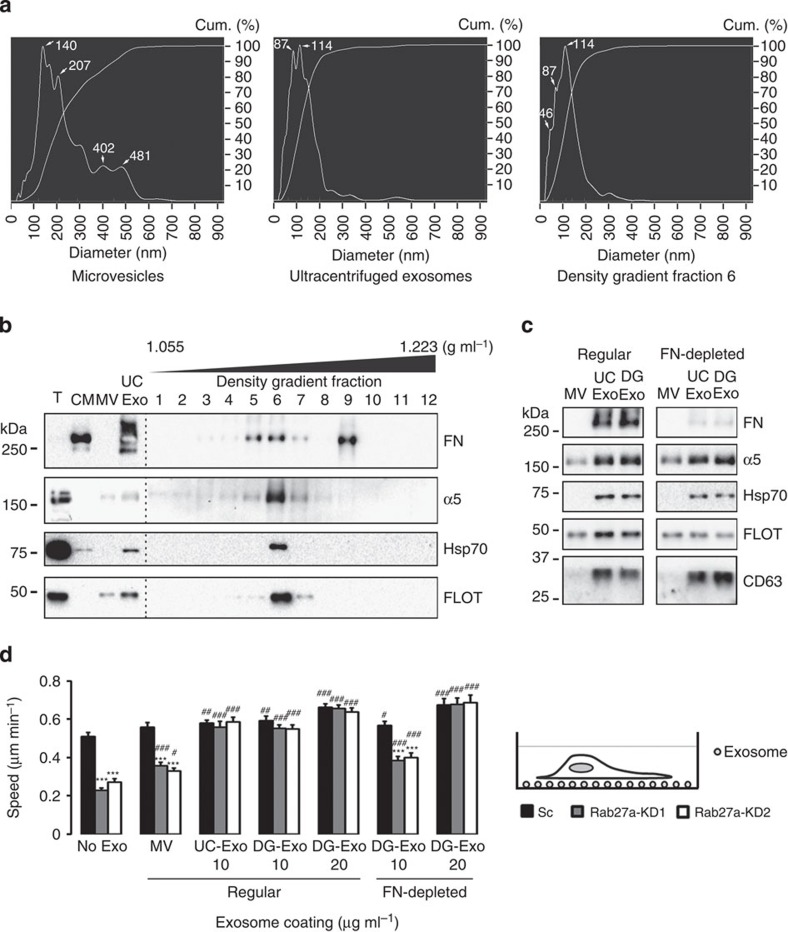
Density gradient-purified exosomes have bound FN and rescue Rab27a-KD cell motility defectsExtracellular vesicles were purified by ultracentrifugation. Microvesicle (Microvesicles) and exosome (Ultracentrifuged exosomes) fractions were analysed by NanoSight (a). Part of the Ultracentrifuged exosomes fraction was further purified by Optiprep density gradient centrifugation. (b) Western blot analysis of the fractions (Density gradient fractions 1–12) for exosome markers HSP70 and flotillin identified Fraction 6 as the major peak containing exosomes. NanoSight analysis of this fraction ((a): Density gradient fraction 6) showed a typical exosome size profile similar to the Ultracentrifuged exosomes profile, whereas Microvesicles fraction contained larger vesicles. Both FN and its receptor α5 integrin were present in the Fraction 6 exosome peak. FN was also present separate from exosome markers in Fraction 9. Conditioned media (CM) contained FN but the microvesicle (MV) fraction did not. T=Total cell lysate. Representative blots from n=2. (c) Western blot analysis of MVs, ultracentrifuge-purified exosomes (UC-Exo) and exosomes present in Fraction 6 density gradients (DG-Exo) from control cells cultured in normal media (Regular) or in FN-depleted media for 10 days. Equal numbers of vesicles were loaded in the gel lanes. Note that FN, HSP70 and CD63 were uniquely present in the exosome samples. Although the lanes are demarcated from each other due to intervening lanes not being shown, the regular and FN-depleted Exo lanes came from the same blot and are directly comparable for all antibodies. (d) The ability of various extracellular vesicles to rescue motility of Rab27a-KD cells was tested by coating 10 μg ml−1 UC-Exo, microvesicles purified from an equivalent number of cells that produced 10 μg ml−1 UC-Exo or 10 or 20 μg ml−1 DG-Exo. Similar to results with UC-Exo (Fig. 4d,h), twice as many DG-Exo purified from FN-depleted cells were required to rescue Rab27a-KD speed as Regular DG-Exo. Data from ≥30 cells from ≥3 independent experiments for each condition. Error bars indicate s.e.m. ***P<0.001 compared with Sc by Student's t-test. #P<0.05; ##P<0.01; ###P<0.001 compared with the same cell line on Exo 0 by Student's t-test.